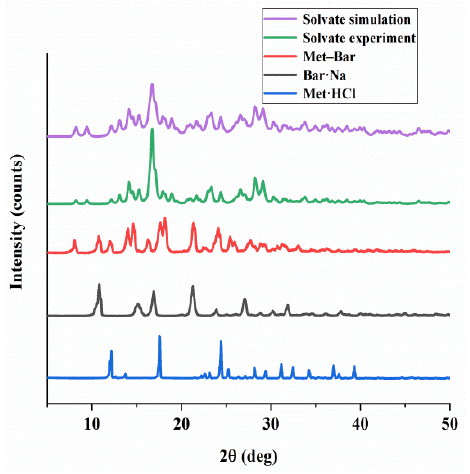
Figure 9 . Powder X-ray diffractograms of Met·HCl, Bar·Na, and Met–Bar. Figure 9. Powder X-ray diffractograms of Met · HCl, Bar · Na, and Met–Bar.